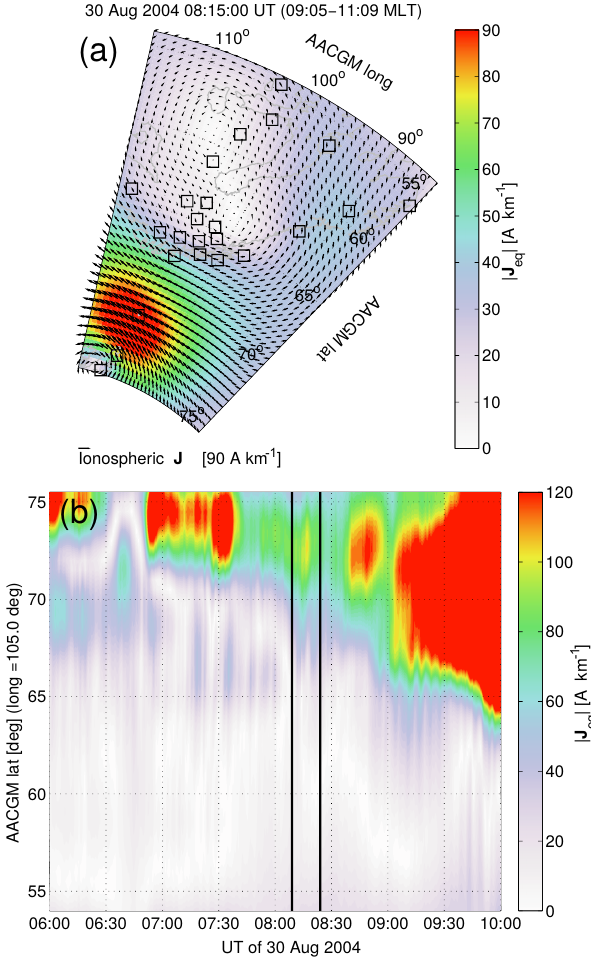
Figure 9. (a) Ionospheric equivalent current density at 110km alti- (cid:12) (cid:12) tude ( J eq , arrows; (cid:12) J eq (cid:12) , colour) in the Northern Hemisphere on 30 August 2004 at 08:15UT, derived from 10s IMAGE magnetometer (squares) data. The data are presented as a function of geomagnetic (AACGM) latitude and longitude, which at the given time corre- spond to 09:05–11:09MLT. The plot has been rotated such that lo- (cid:12) (cid:12) cal noon is at the top. (b) (cid:12) J eq (cid:12) keogram (latitude profiles along 105 ◦ longitude presented as a function of time between 06:00 and 10:00UT). The vertical lines indicate the interval (08:09–08:24UT) during which Geotail observed the ion beam signature.